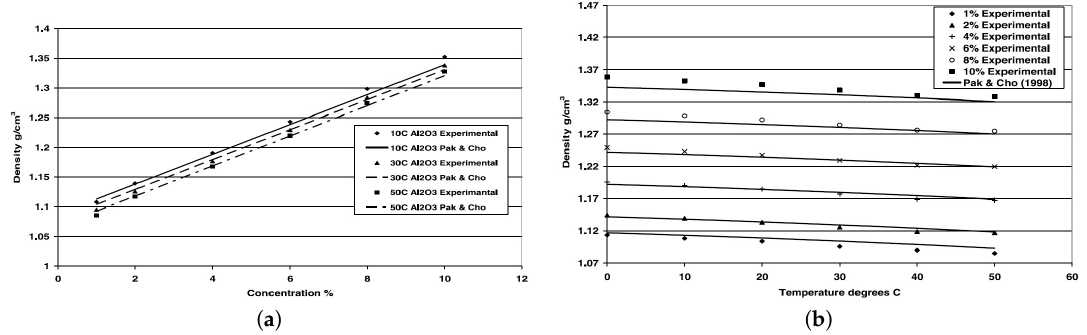
Figure 1. Comparisons between the density measurements of Vajjha et al. [36] and the Pak and Cho [37] equation for Al 2 O 3 nanofluids: ( a ) influence of concentration at three temperatures and ( b ) influence of temperature for six nanoparticle concentrations. The base fluid is a mixture of 60:40 ethylene-glycol/water by mass. After [36], with permission from Taylor and